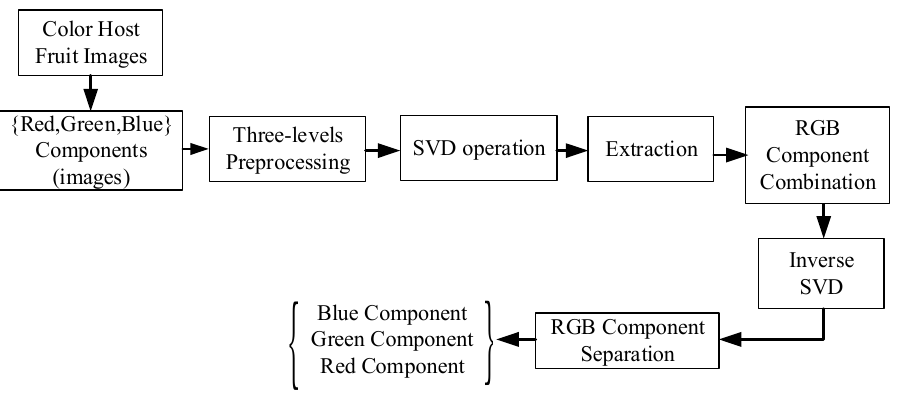
Figure 2. Flowchart of the extraction process of the SVD algorithm .